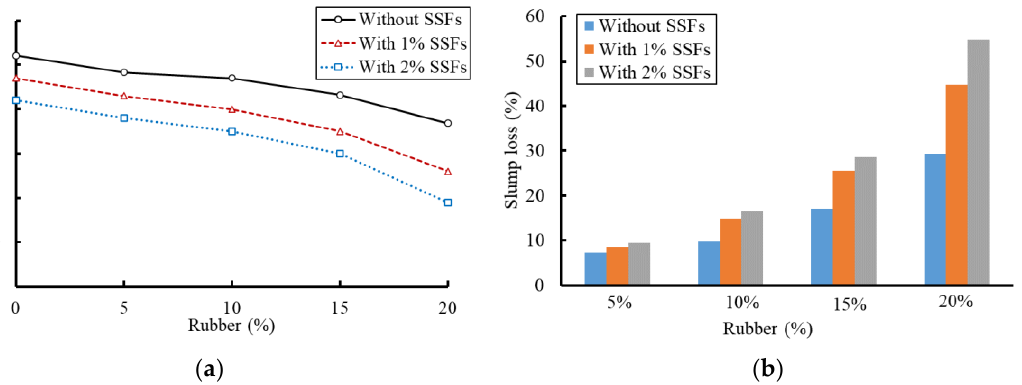
Figure 6. Slump test results for all concrete mixes. ( a ) Effect of CR and SSFs on slump test values. ( b ) Percentage of slump loss.